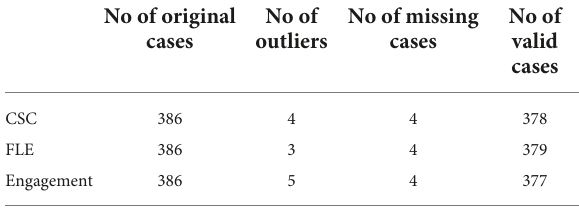
TABLE 1 Number of cases for each measure.